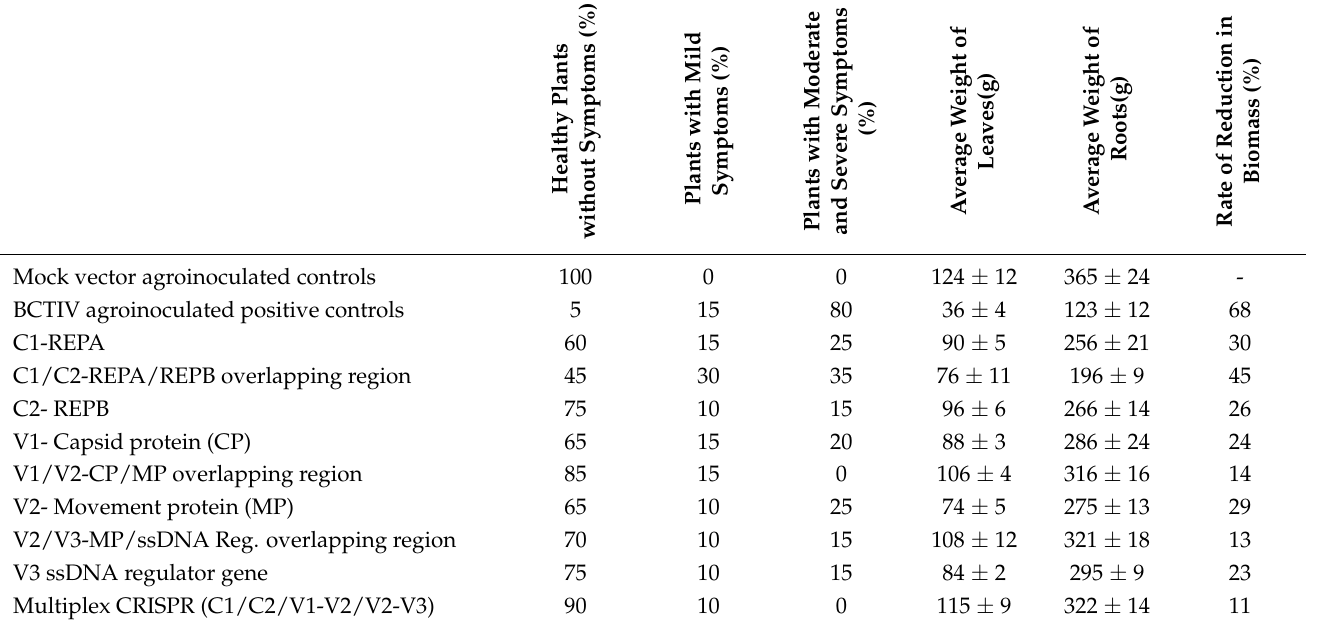
Table 1. Biomass and beet curly top disease (BCTD) symptoms were recorded for 40 sugar beets co-agroinoculated with gRNA/Cas9 and BCTIV or only BCTIV and mock vector. The rate of dis- ease formation and biomass reduction was compared with the mock vector-agroinoculated healthy sugar